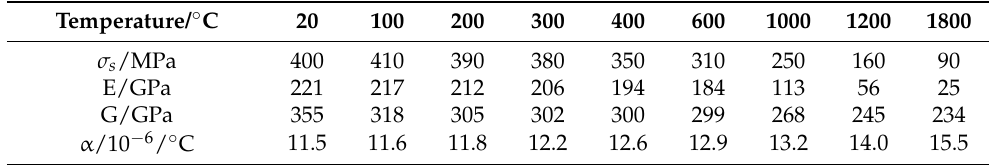
Table 5. Mechanical property parameters of Ni60 powder.